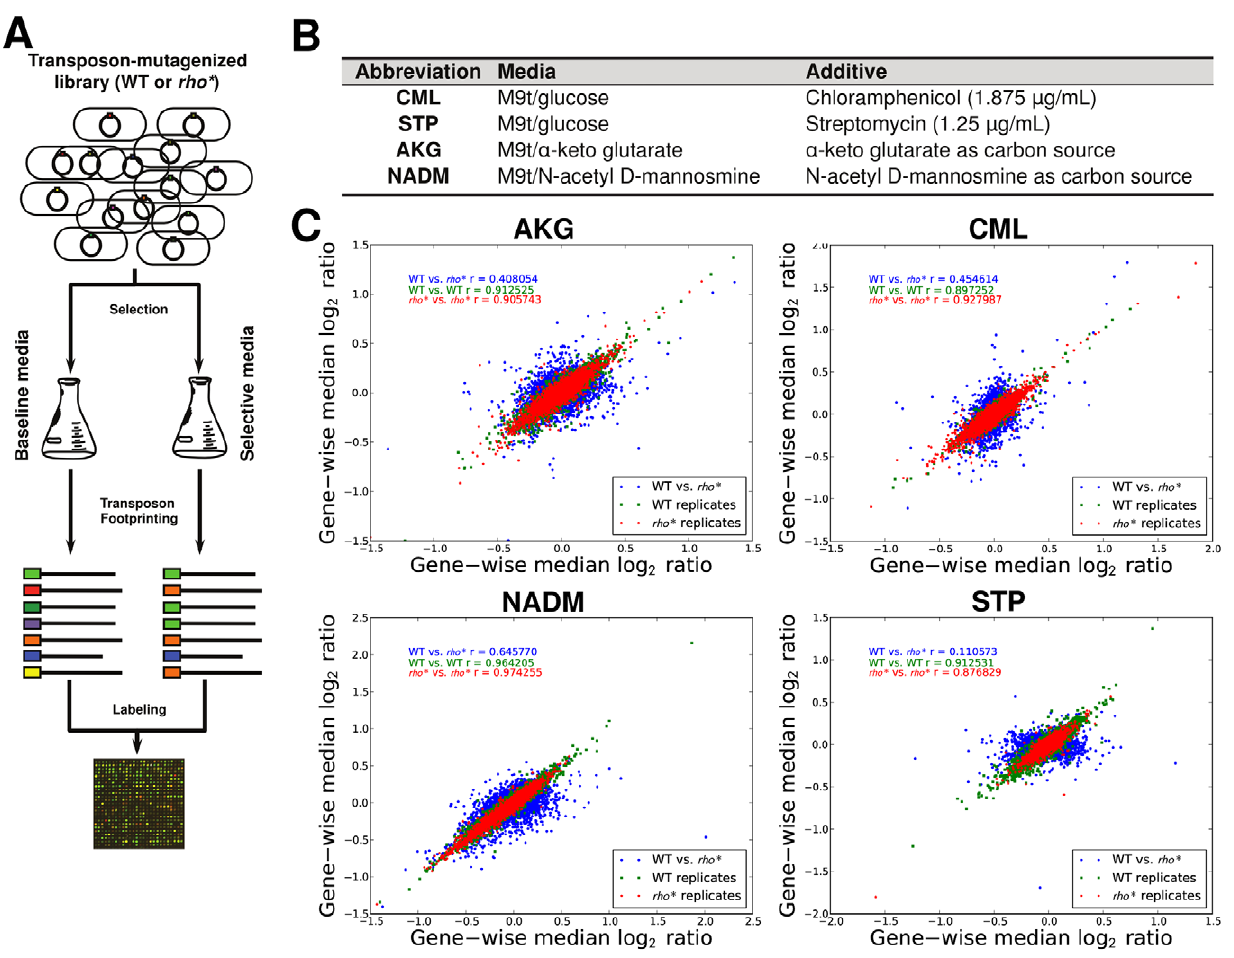
Figure 2. Mapping of fitness landscapes of WT and rho * cells using transposon-mutagenized libraries. (A) Procedure used to identify loci with significant fitness contributions. Transposon mutagenized libraries were constructed separately in the WT and rho * strains, and then grown in parallel under selective conditions and a reference condition. Genomic regions adjacent to transposons were then selectively amplified. The abundances of transposon insertions throughout the genome were compared between the condition of interest and the reference condition using a two-color microarray. (B) Selective conditions used; M9t/glucose was the reference condition in all cases. (C) Comparison of gene-wise median fitness scores (log 2 ratio of reference:selected microarray signals) between WT and rho * cells under each condition. For reference, a similar comparison between the two biological replicates of each strain/condition pairing is also shown. Pearson correlations (r) are given between WT and rho * signals or between replicate experiments for isogenic cells, as appropriate.